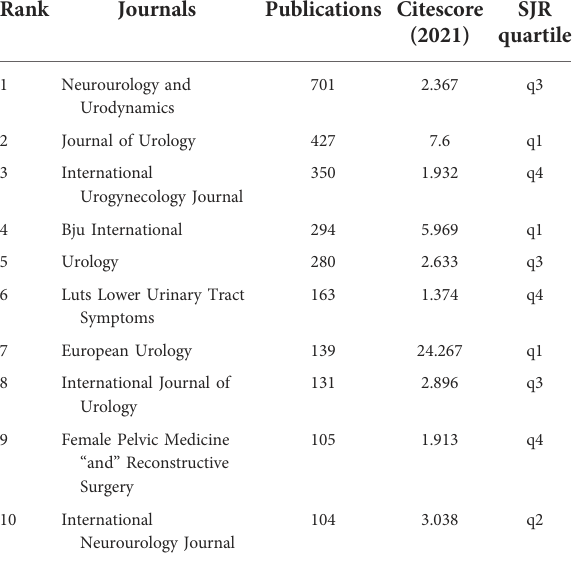
TABLE 3 Top 10 journals publishing original human studies on the topic of overactive bladder.